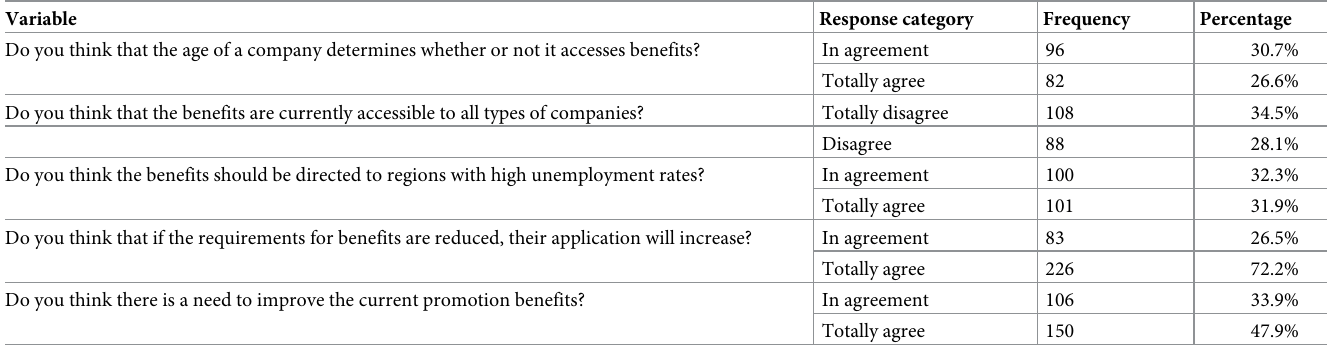
Table 1. Perception of the general aspects of the state support